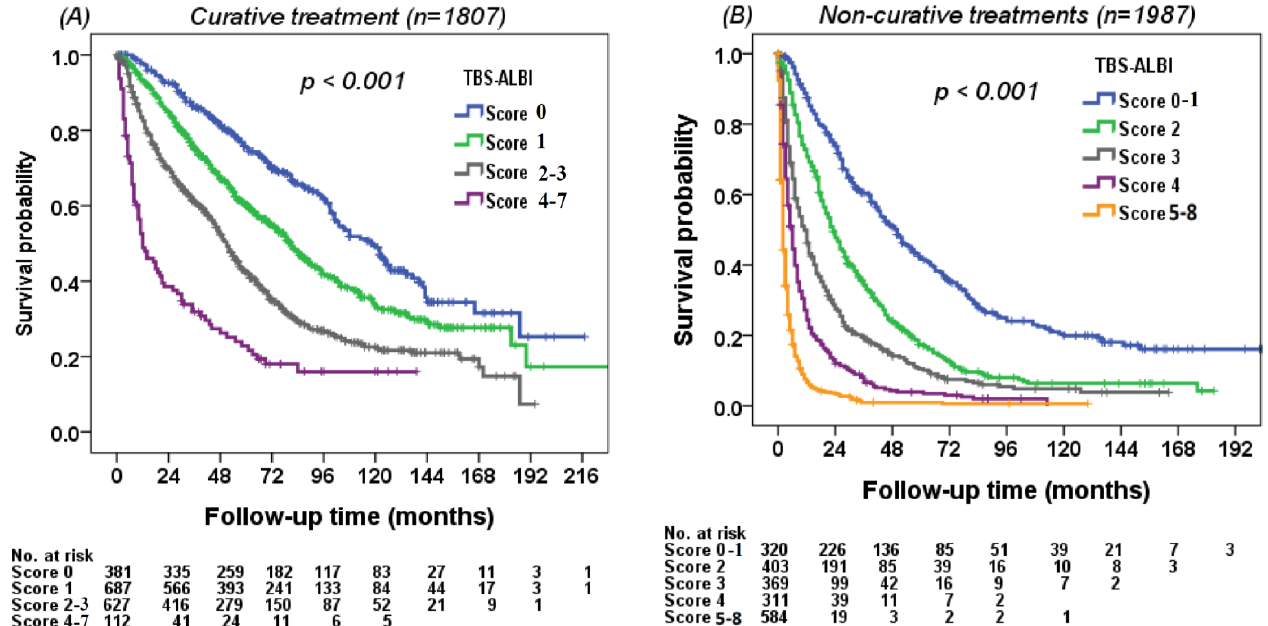
Figure 5. Survival distribution according to the TBS–ALBI system in patients receiving ( A ) curative and ( B ) non-curative treatments. Patients with high TBS–ALBI scores had increased risk of mortality compared with those with lower scores in patients receiving curative ( p < 0.001; n=1807) and non-curative treatments ( p < 0.001; n = 1987).